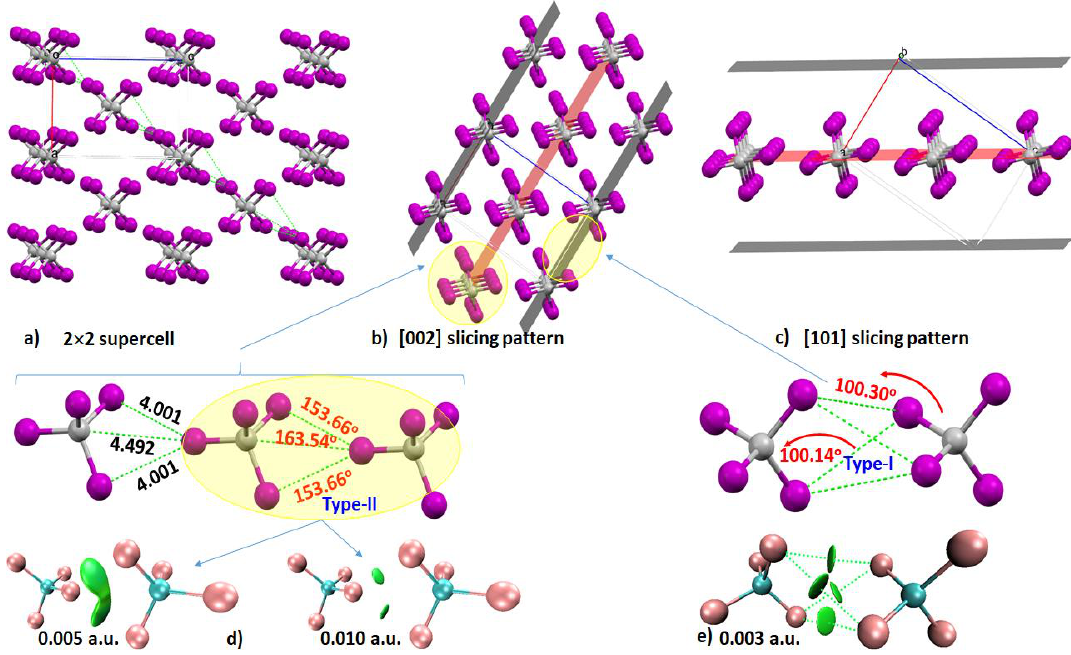
Figure 13. The ball-and-stick models of the CI 4 crystal (CSD ref. code: ZZZKDW01)). ( a ) Unit cell and 2 × 2 supercell and ( b ) [002] slicing pattern. ( c ) [101] Slicing pattern. Type-II and -I bonding patterns between interacting monomers in the crystal are shown in ( d , e ), respectively, with the IGM isosurfaces corresponding to these interactions in green volumes.